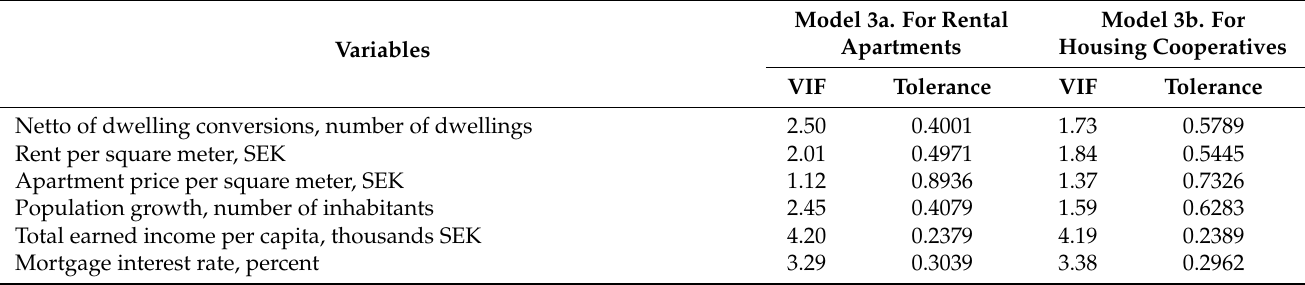
Table A6. Results of the VIF tests on variables in models 3a and 3b.